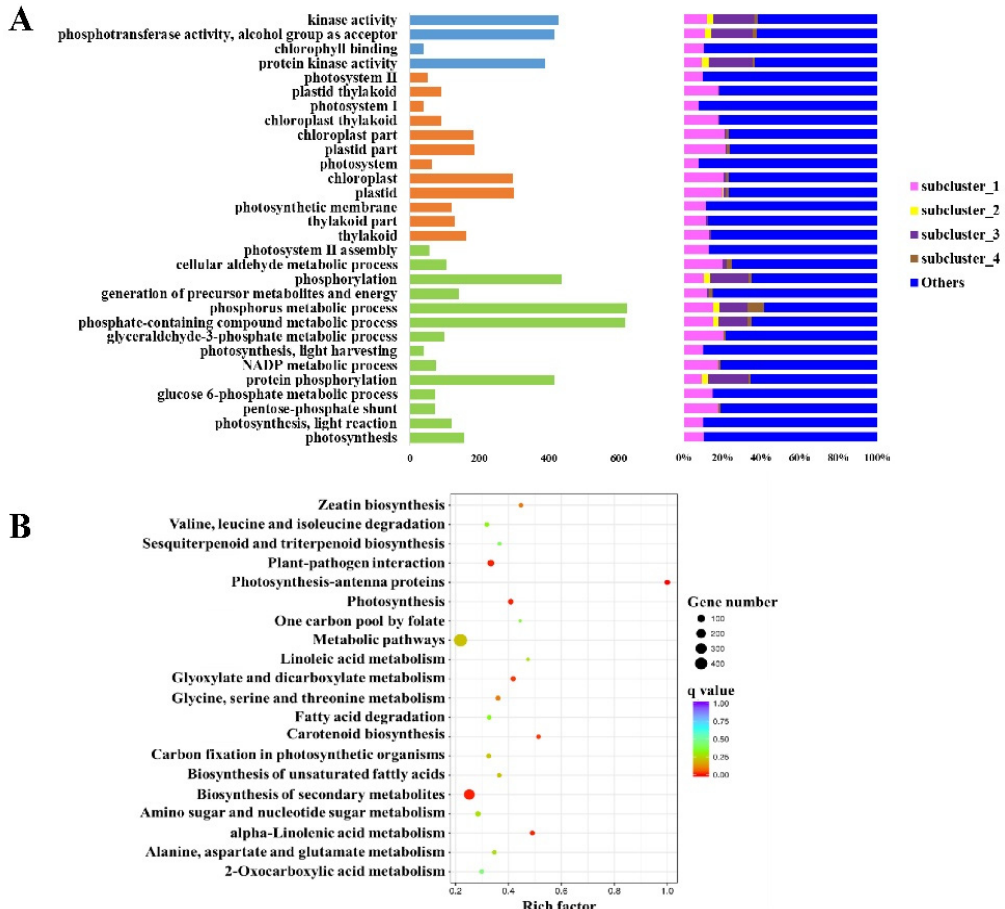
Figure 4. The enrichment analysis of DEGs at different infection time points. ( A ) GO enrichment of DEGs in group Pi24h vs. Pi0h (left) and the proportion of genes from 4 subclusters in each GO term (right). The histogram intuitively reflects the distribution of the number of DEGs in GO terms enriched in biological processes (BP), cellular components (CC) and molecular functions (MF). We selected the 30 GO terms with the most significant enrichment to show in the figures. Green, orange and blue histogram represent BP, CC and MF, respectively. The histograms of GO enrichment at the other two time points are shown in the supplementary material. In the KEGG enrichment results of DEGs ( B ), we selected the 20 most significantly enriched pathway entries for display in the graph. The ordinate indicates the name of the pathway, the abscissa indicates the Rich factor, the size of the dot indicates the number of differentially expressed genes in the pathway, and the color of the dot corresponds to different Qvalue ranges. Only the results of Pi24h vs. Pi0h are shown here, while the results at other time points are shown in the Supplementary Materials.